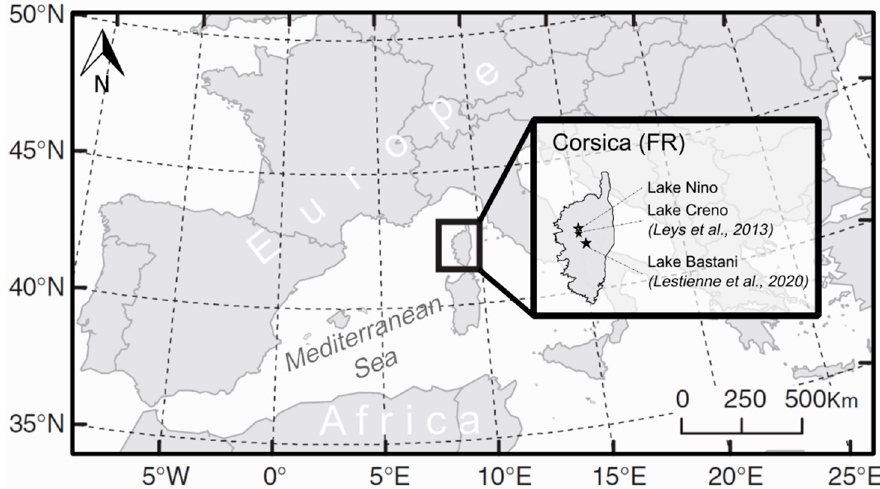
Figure 1. Geographical context of Corsica (France) and lakes from which sedimentary charcoals were extracted: Nino (the present study), Creno [42], and Bastani [33] .